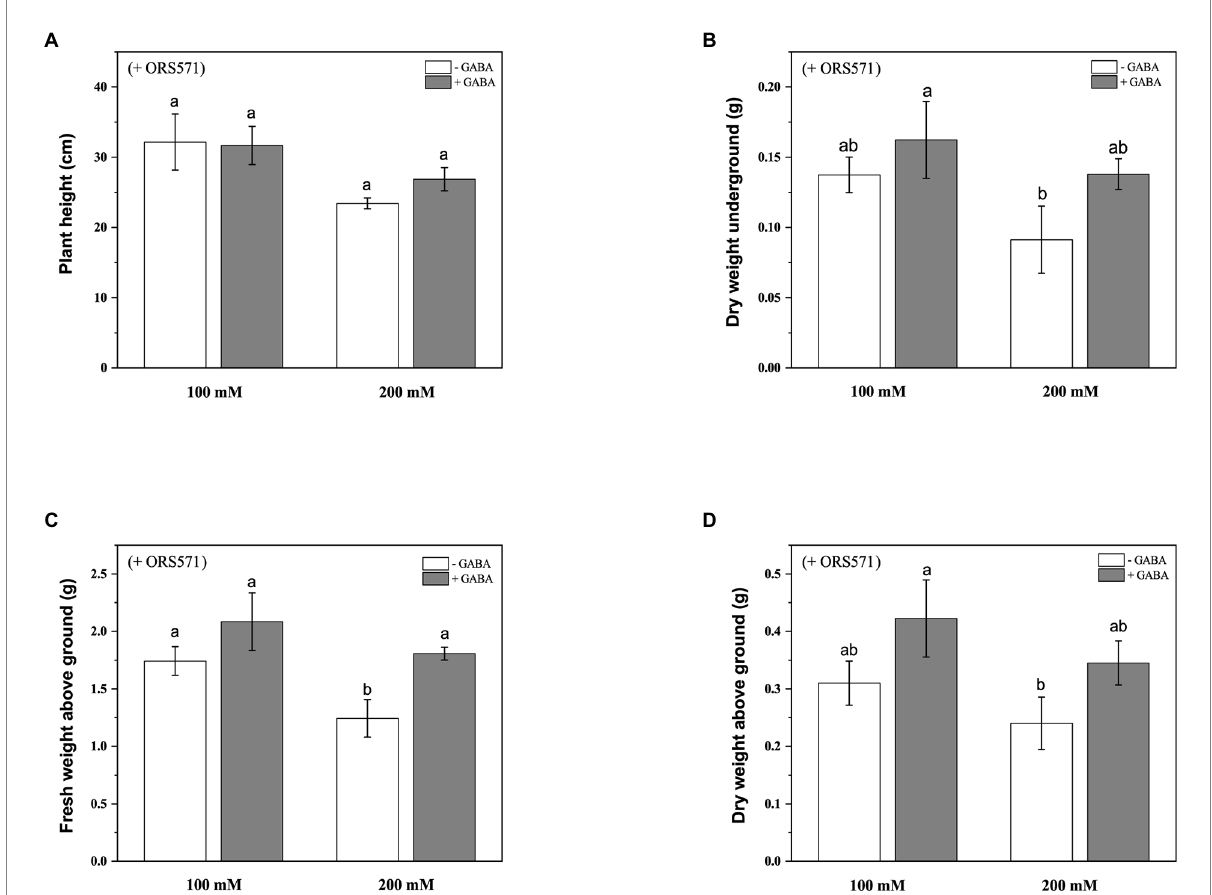
FIGURE 6 Effects of exogenous addition of GABA on the biomass aboveground/underground and plant height of ORS571 -Sesbania rostrata symbiotic system under different salt concentrations. The plant height (A) , DW underground (B) , FW above ground (C) , and DW above ground (D) were measured. Different lower-case letters in each column shape indicate a significant difference at p < 0.05 by statistical analysis. Error bars indicate standard deviations from four parallel